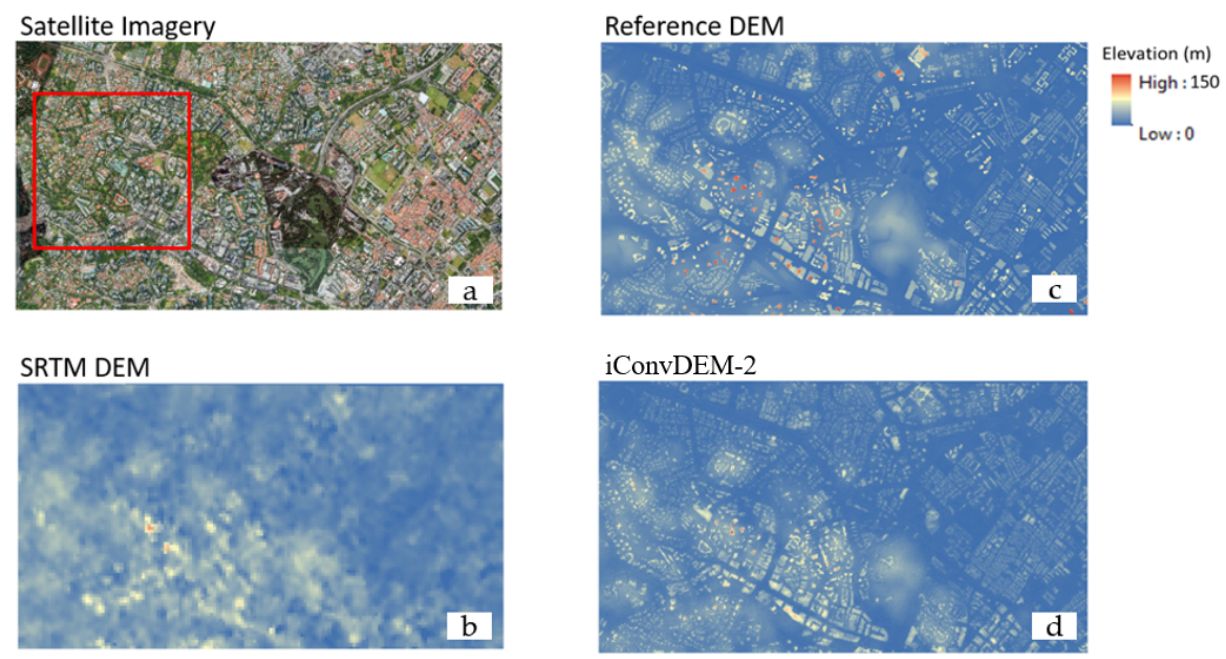
Figure A1. Plots at the validation site in Nice of: ( a ) satellite image, ( b ) SRTM DEM, ( c ) reference DEM and ( d ) iConvDEM-2.